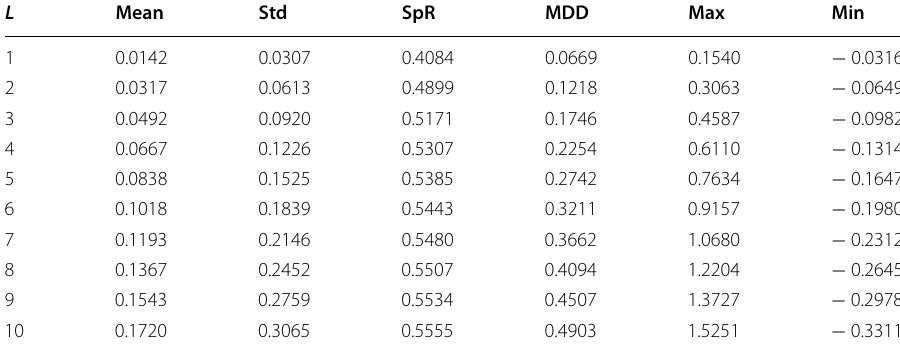
Table 10 Parameter sensitivity analysis of L in intelligent option model